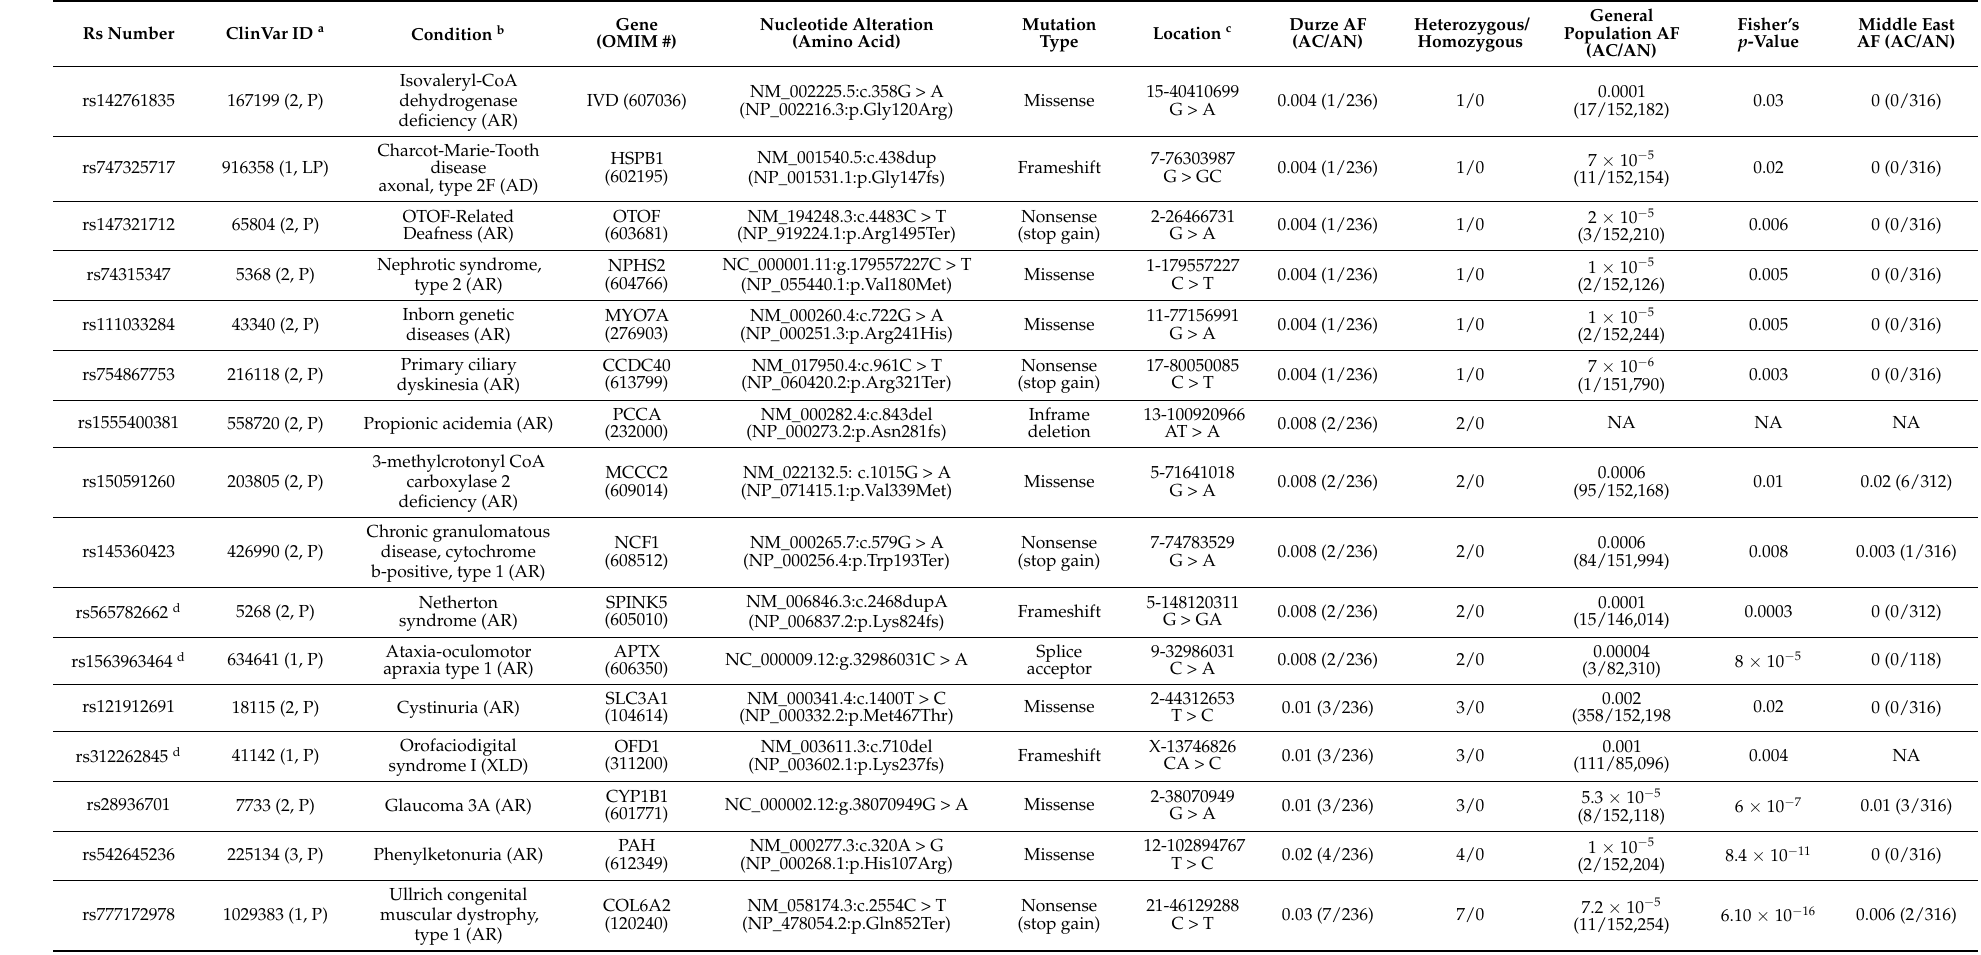
Table 1. Potentially clinically relevant genes and variants in Druze from exome sequencing